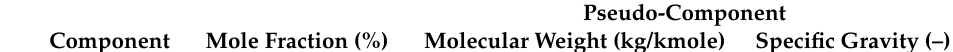
Table 1. Wellfluid composition and hypothetical characterization for the investigated well fluid